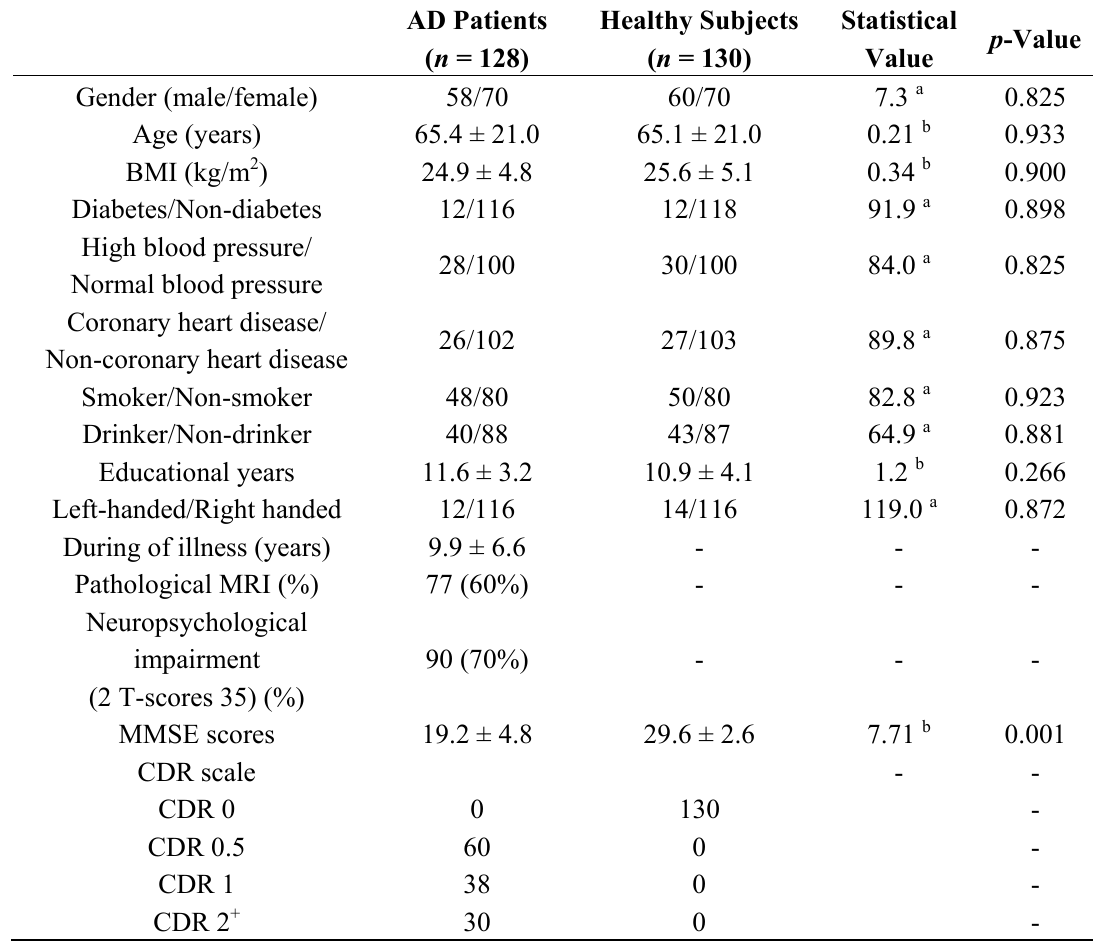
Table 1. Baseline characters of study patients and healthy